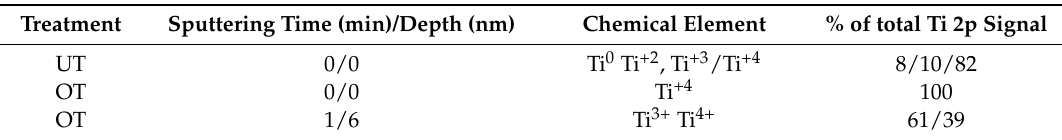
Table 1. Variation of the titanium oxide composition as a function of depth for different surface treatments studied (UT: untreated samples; OT: treated samples).